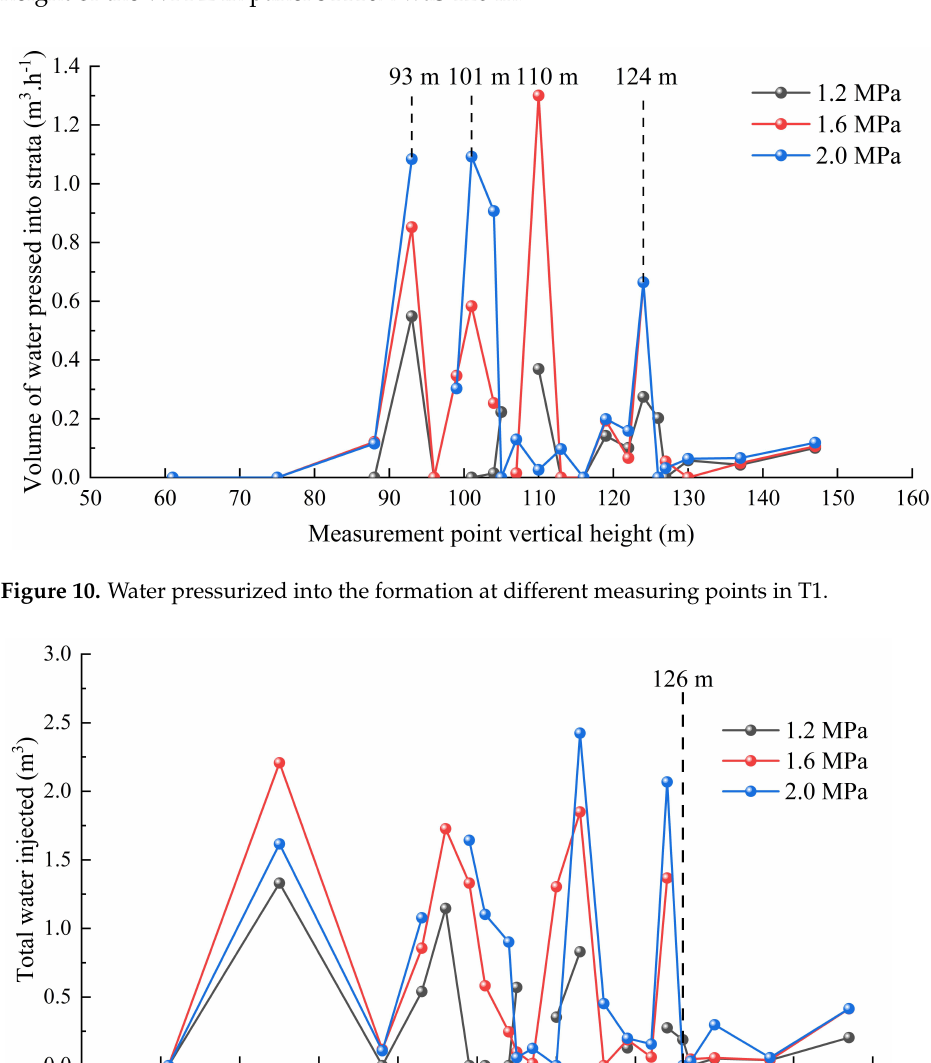
Table 3. Comparison of the prediction results of the different models.